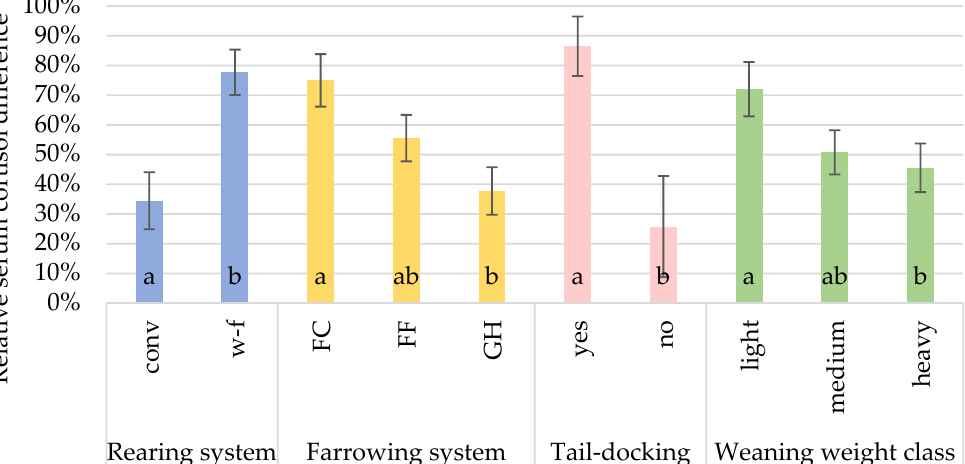
Figure 4. Estimated relative difference of serum cortisol before and after weaning, in percent, for the